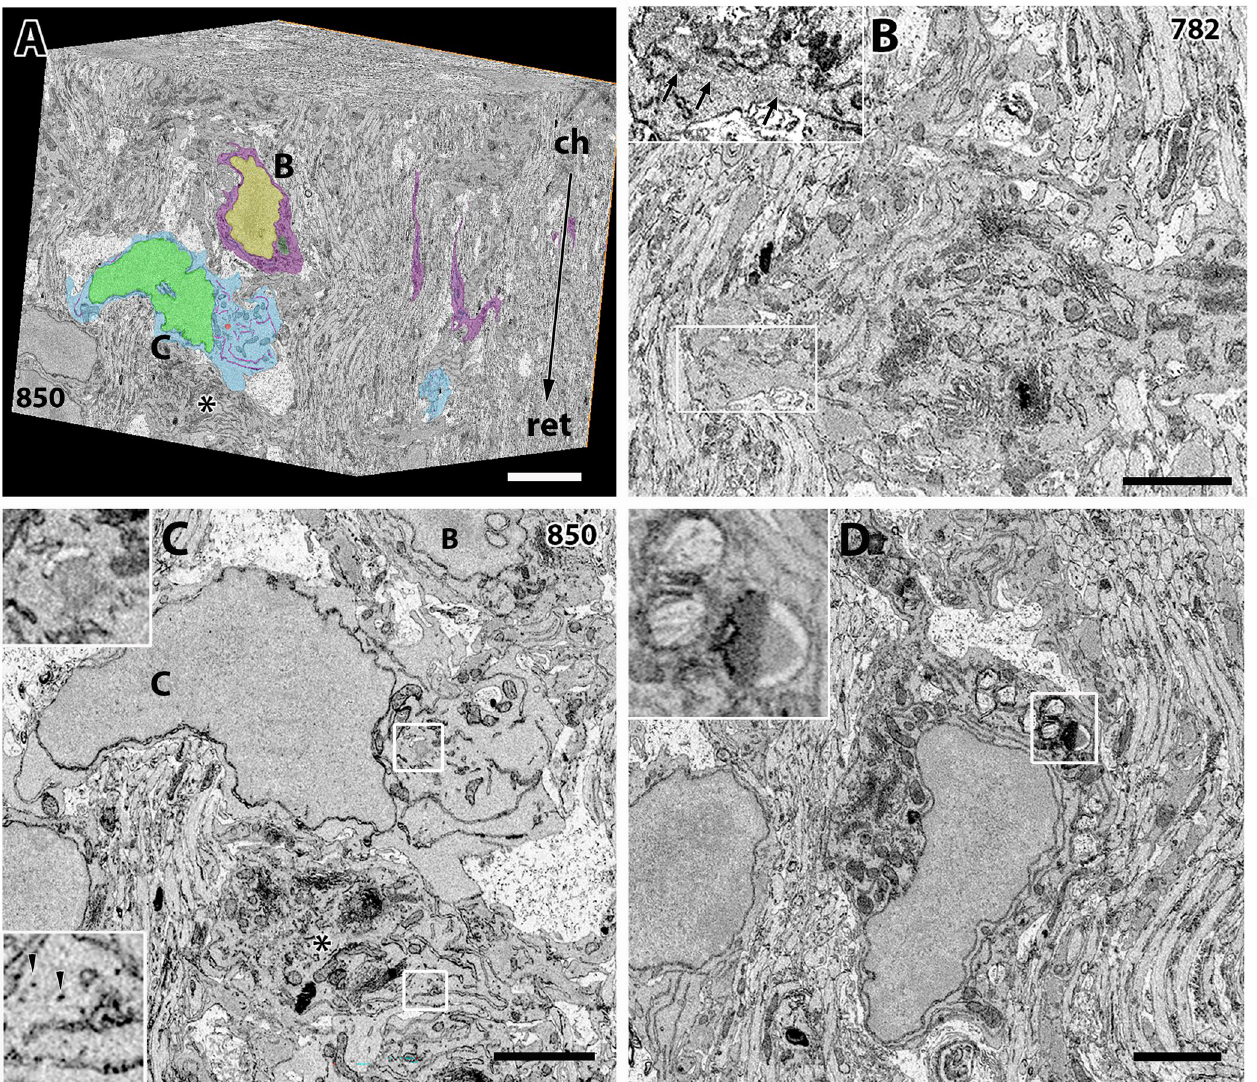
Fig 1. Glial cells imaged by SBF-SEM. (A) 3D reconstruction of a brain volume obtained from SBF-SEM images of the P4 optic nerve. An astrocyte with magenta color indicated by B is magnified in B, and a pOPC with light blue color indicated by C is magnified in C. An asterisk indicates another astrocyte magnified in C. Upper part of the cube block on the chiasmal side (ch) and the lower part on the retinal side (ret). The section number within the serial images was 850. (B) Higher magnification image of the astrocyte labeled as B in A, but 68 sections apart from A. The boxed area is magnified in the inset (upper left) and shows a bundle of intermediate filaments (arrows in the inset). Note the richness of cytoplasmic organelles in this astrocyte. (C) Higher magnification image of the pOPC labeled as C in A. Notably, the density of the cytoplasmic organelles in pOPC is much sparser compared with astrocytes (B) or microglia (D). A centriole within the boxed area of cell C is magnified in the upper inset. Another boxed area in the cell indicated by an asterisk contains glycogen granules and is magnified in the lower inset. (D) Higher magnification image of microglia. Note that dense bodies of lysosomes are contained in this cell and are magnified in the inset. Bars = 2 μ m. B and C are magnified in S1 and S2 Figs,